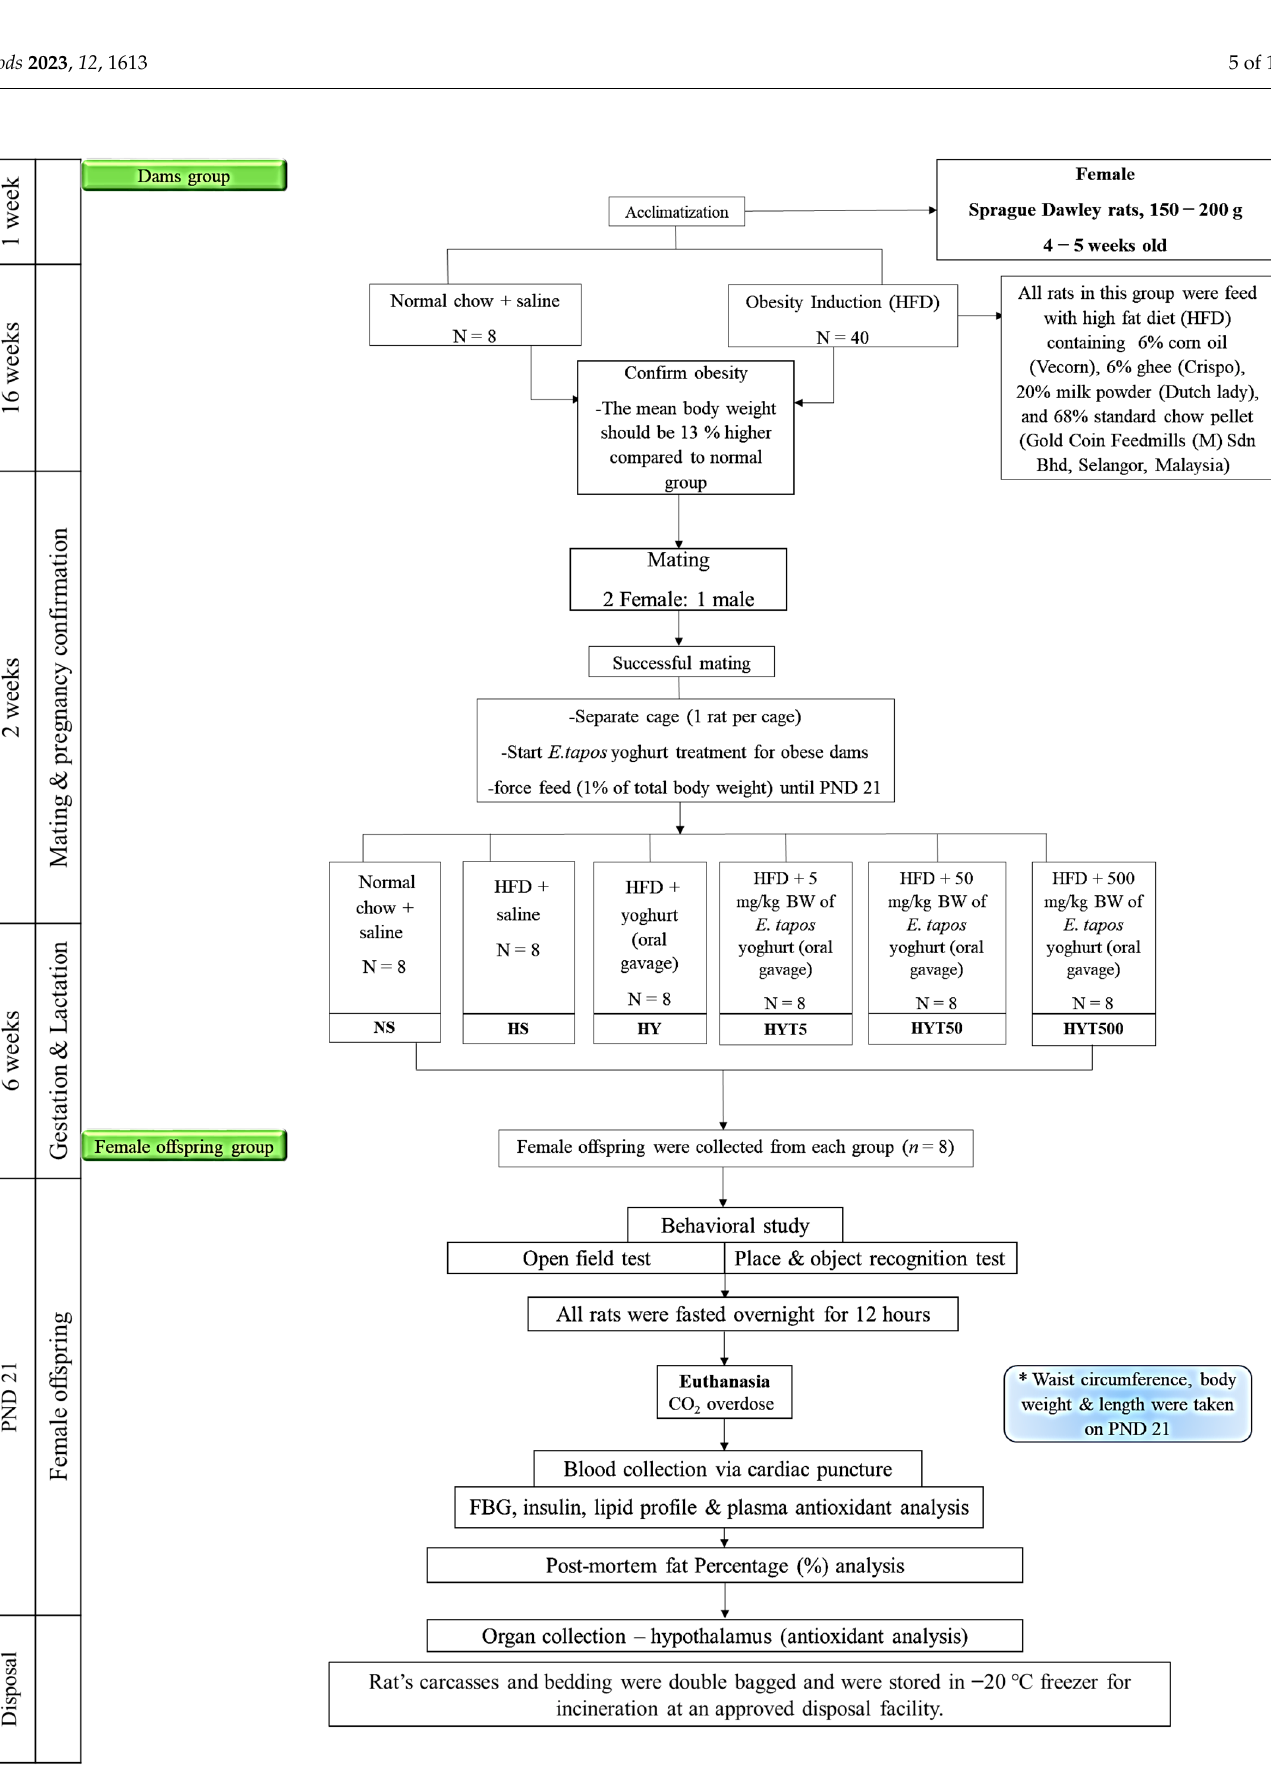
Figure 1. The experimental design.